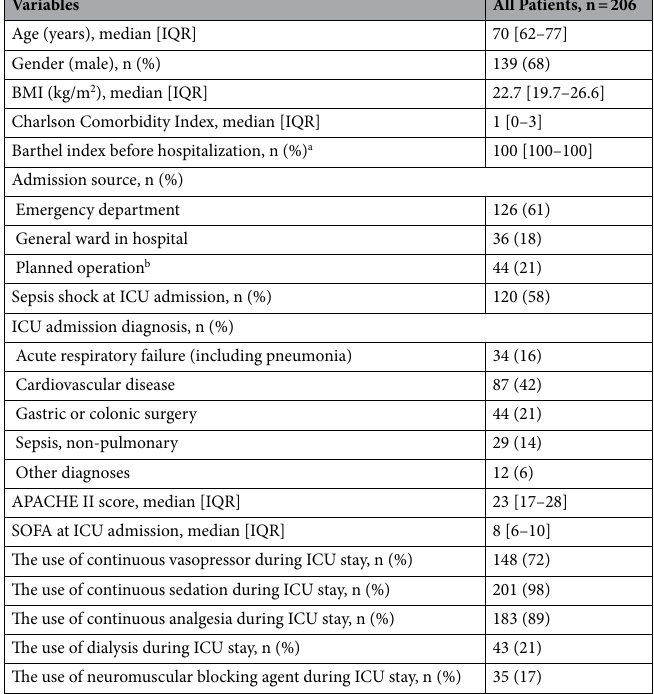
Table 1. Baseline characteristics at the time of intensive care unit admissions. Data are presented as median [interquartile range] or number (%). IQR interquartile range, BMI body mass index; ICU intensive care unit, APACHE acute physiology and chronic health evaluation, SOFA sequential organ failure assessment. a Barthel index before hospitalization was scored at the time of ICU admission based on the information from the family or the patients if they were conscious. b Breakdown of post-operation: cardiovascular surgery, 27 (61%); Gastrointestinal surgery, 11 (25%); other surgery, 6 (14%).